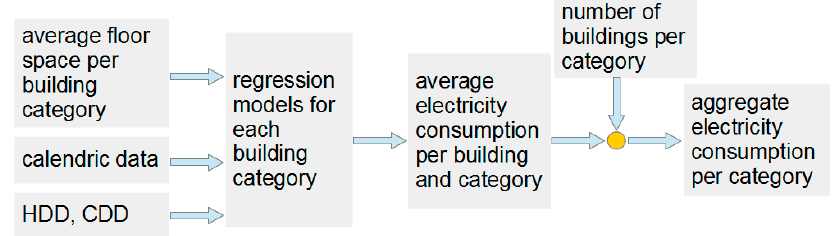
Figure 5. Modeling aggregate hourly electricity consumption in different service sector categories.